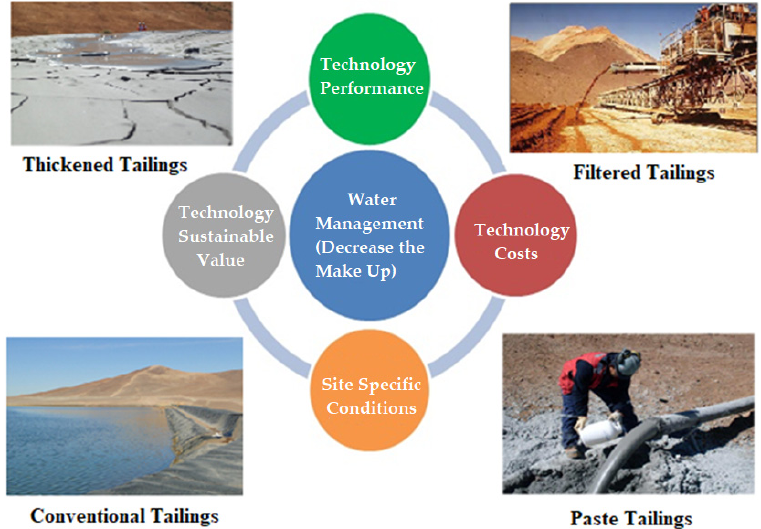
Figure 5. Dewatering Tailings Technologies—Efficient Water Management.